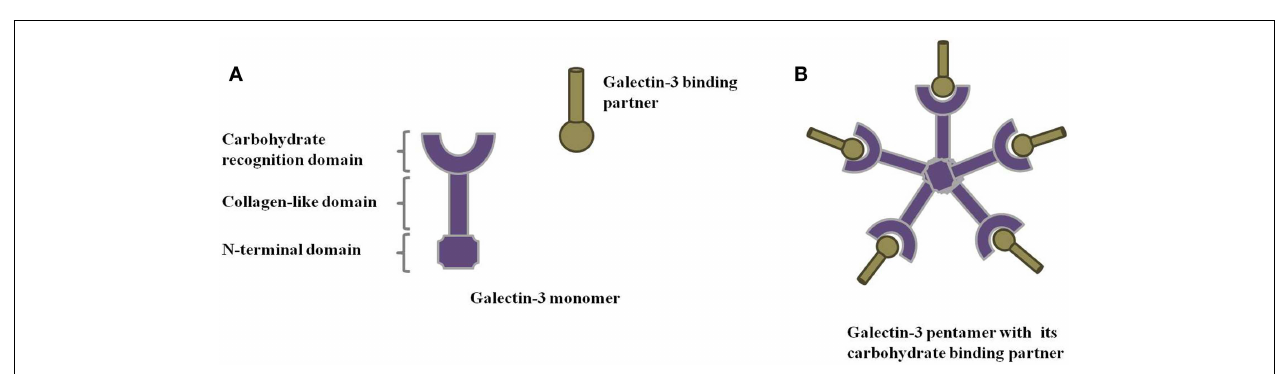
FIGURE 1 | Galectin-3 structure . Schematic representation of (A) galectin-3 monomer and (B) galectin-3 oligomerization through its N-terminal domain in the presence of its binding partners.